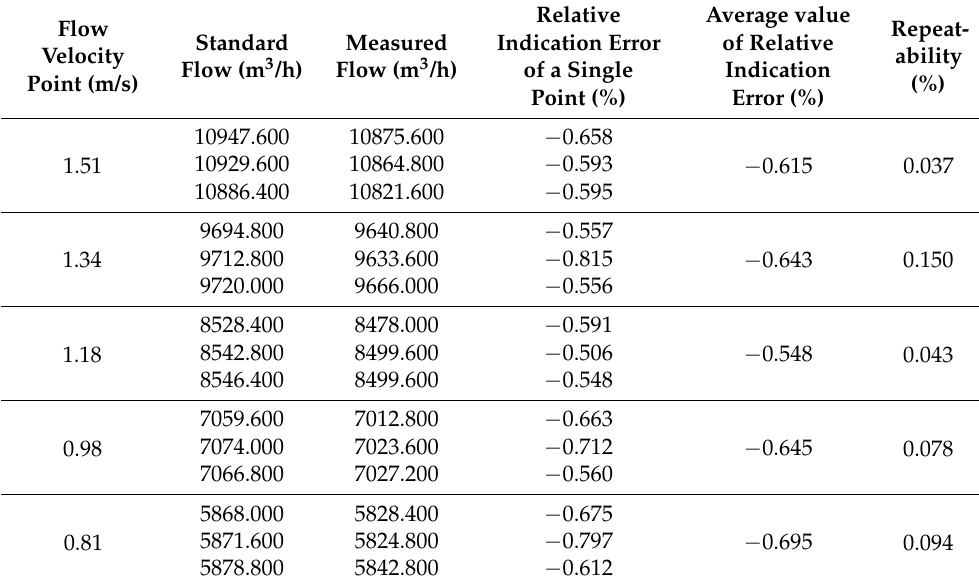
Table 8. Measurement results under DN1600 pipe